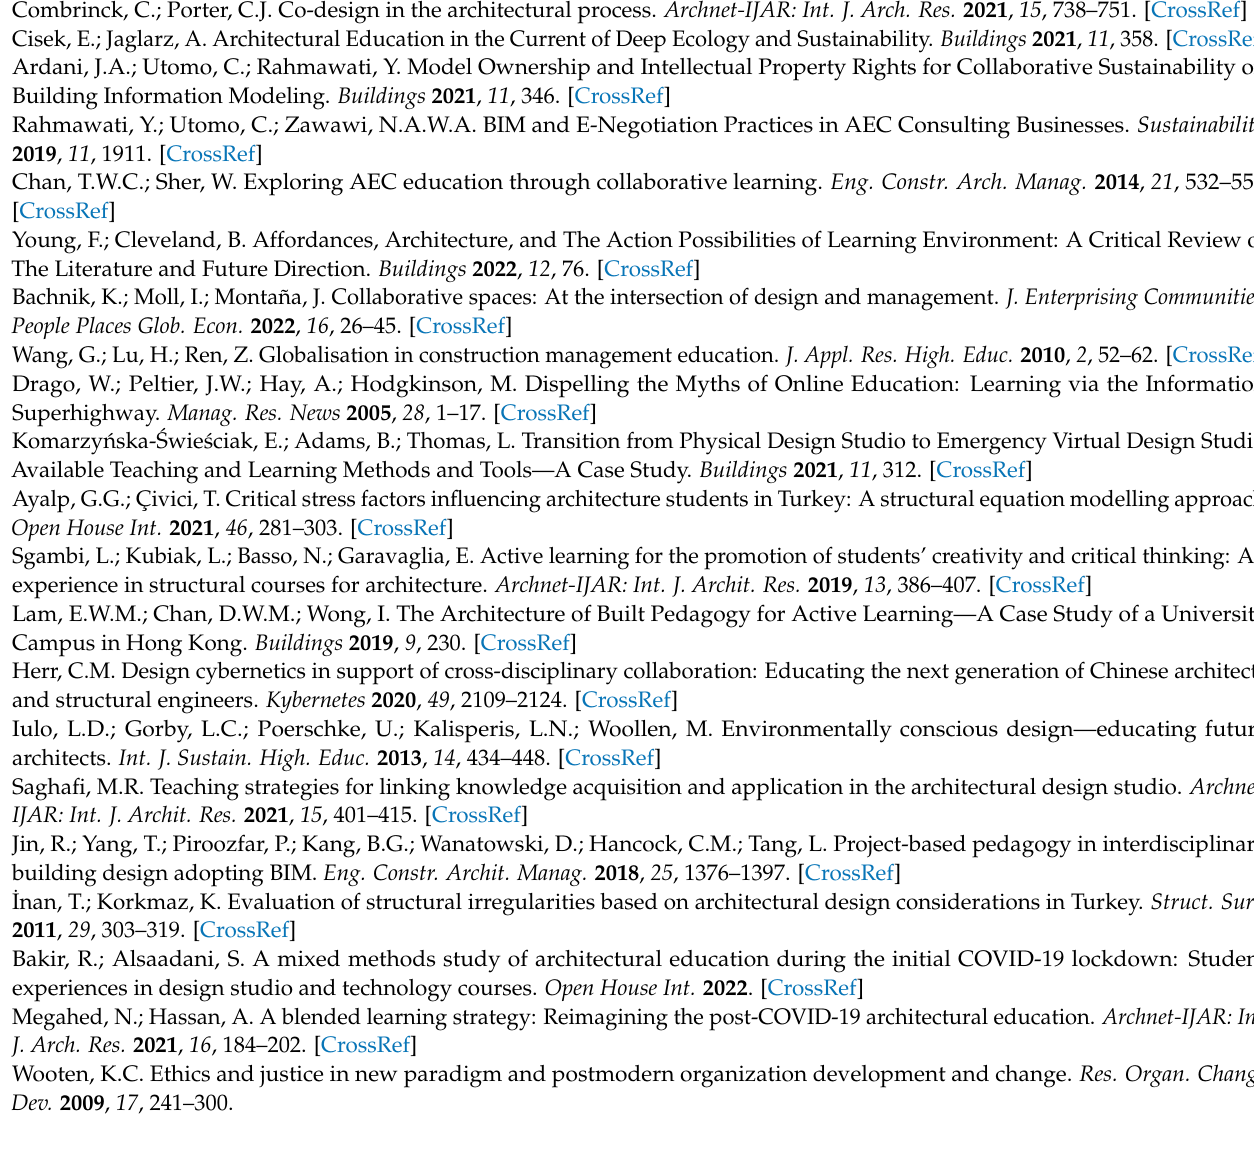
Figure A5. Chaoroof. Figure A5.